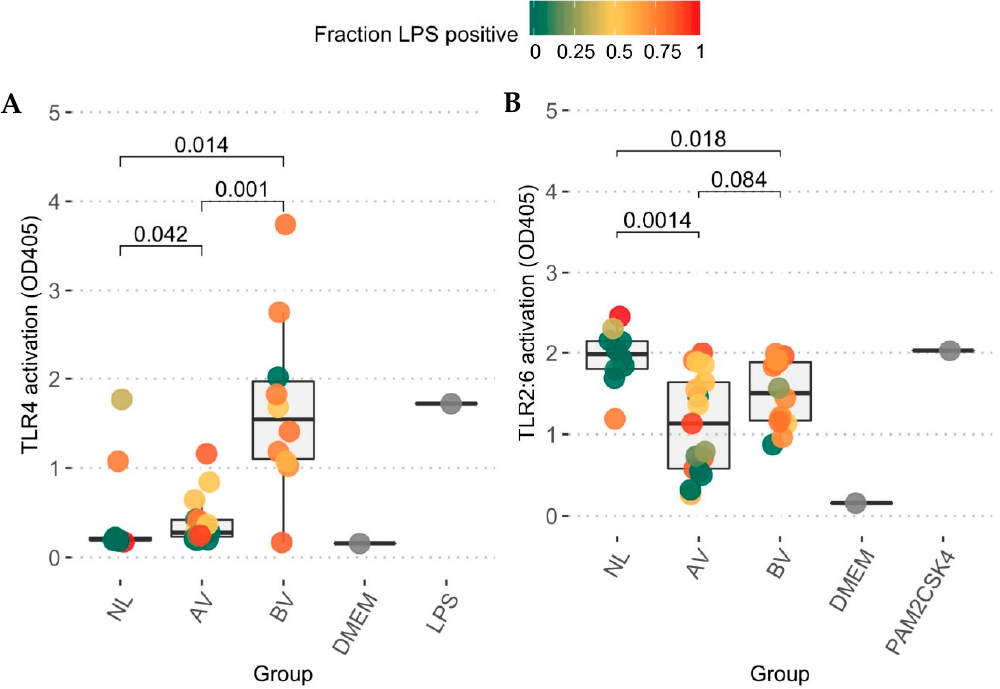
Figure 4. HEK-Blue hTLR4 and HEK-Blue hTLR2-TLR6 cell response after stimulation of diluted samples. Formation of p-nitrophenol, generated by alkaline phosphate, induced by ( A ) TLR4 or TLR2-TLR6 ( B ) stimulation was measured through spectrophotometry by its absorbance at 405 nm ( Y -axis). The individual dots are colored according to the cumulated relative abundances of LPS positive taxa (Gram-negative and Gram-variable) as LPS is the clear ligand of TLR4, while the dimer of TLR2 and TLR6 is generally more responsive to Gram-positive ligands (peptidoglycan, lipoteichoic acid). The grey dots indicate the blank measurements (mean = 0.156 and 0.155) and the positive controls (LPS, 10 ng / mL, mean = 1.72 ± 0.05 sd and PAM2CSK4 50 ng / mL, mean = 2.03 ± 0.07 sd). p -values are indicated, as obtained from a pairwise Wilcoxon test corrected for multiple testing.